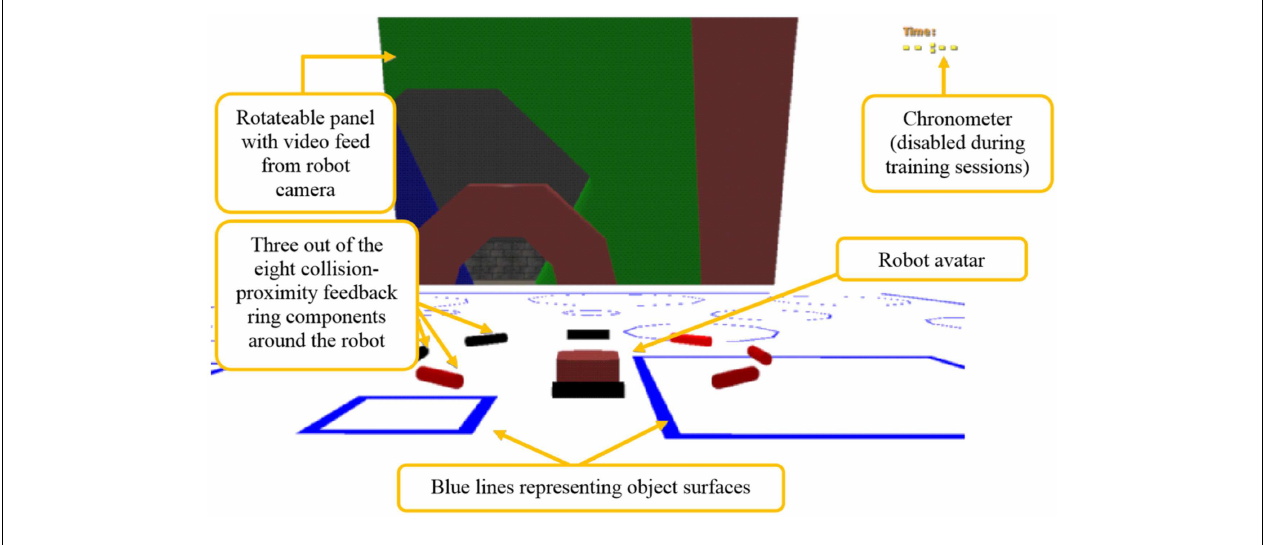
FIGURE 2 | Study #1 visual interface components